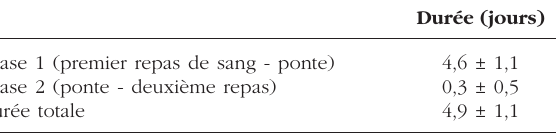
Tableau II. - Durée des différentes phases du cycle gonotrophique d’ An. labranchiae